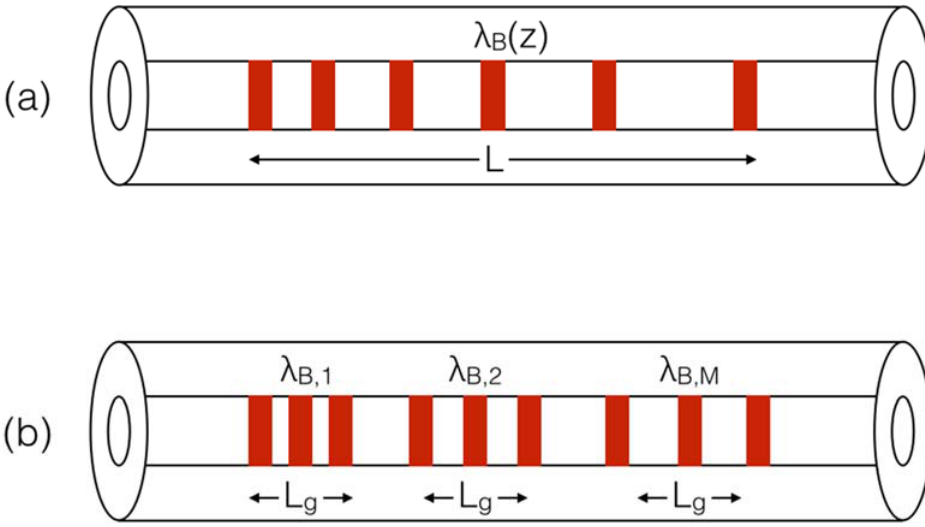
Figure 1. Schematic of a CFBG and its incoherent discretization method. ( a ) Sketch of a linearly chirped FBG; ( b ) correspondent discretization of the CFBG into M uniform FBGs.